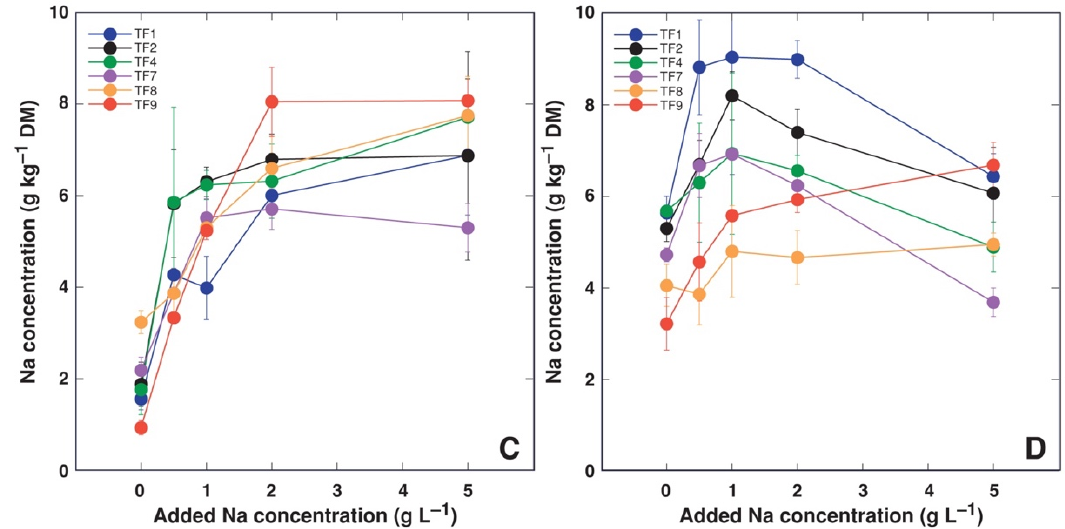
Figure 7. Effect of increasing substrate salinity on Na + accumulation in leaf blades ( A ), leaf petioles ( B ), stolons ( C ) and roots ( D ) of Trifolium fragiferum plants of different accessions.